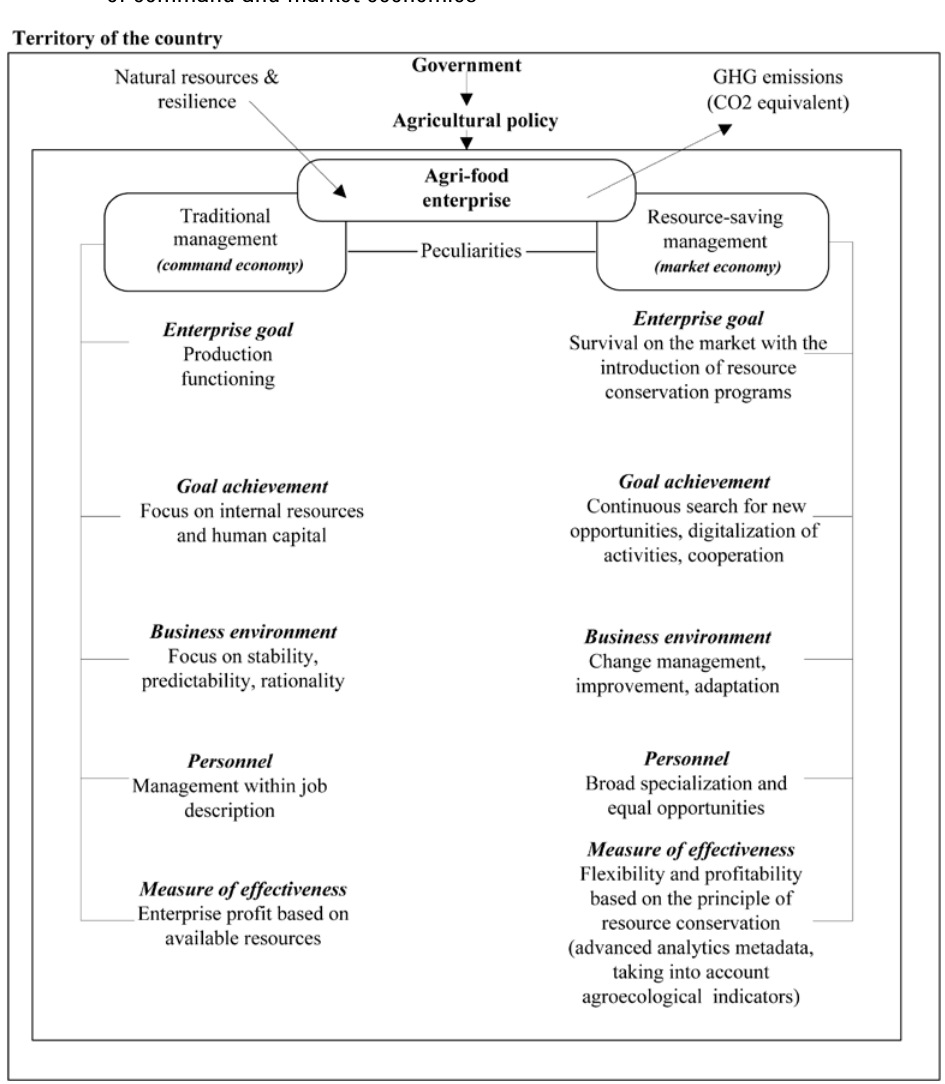
Figure 5. Resource-saving management scheme for an agri-food enterprise in the context of command and market